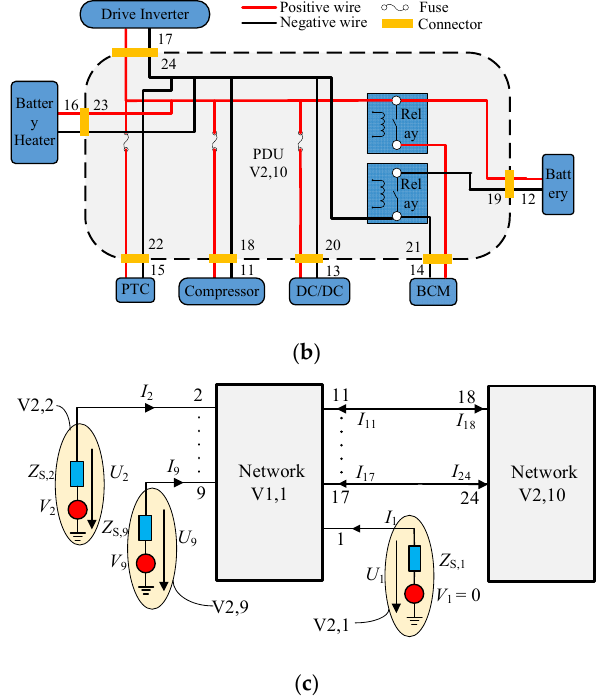
Figure 6. Modelling process: ( a ) Schematic diagram of power system; ( b ) Schematic diagram of PDU; ( c ) Topological multi-port network diagram.